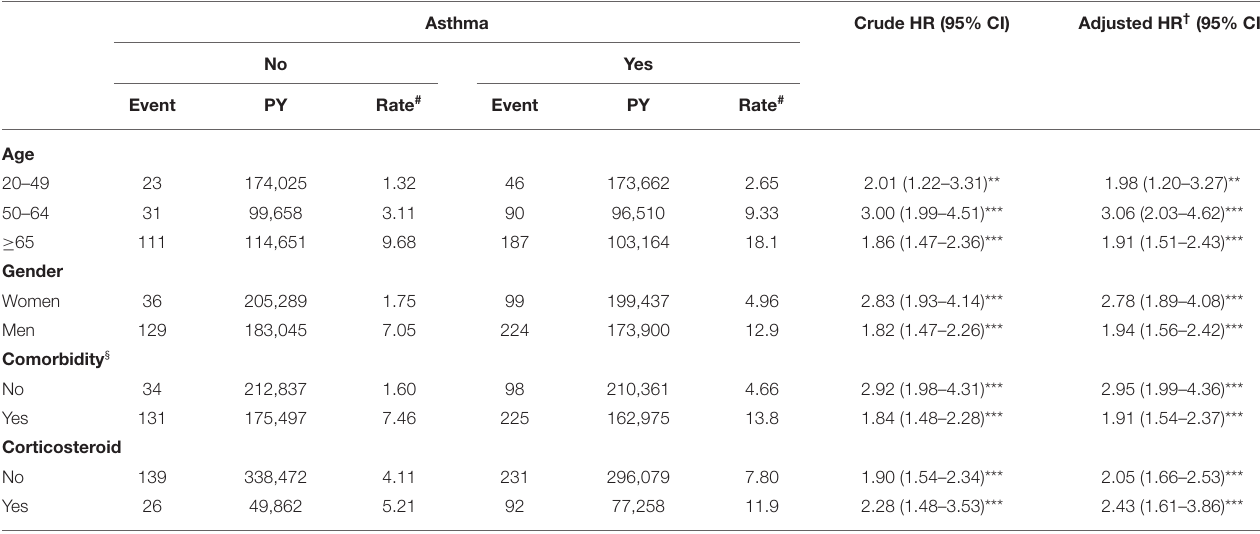
TABLE 3 | Incidences and hazard ratios of pleural empyema by age, gender, comorbidity, and corticosteroid use between asthma and non-asthma cohorts.